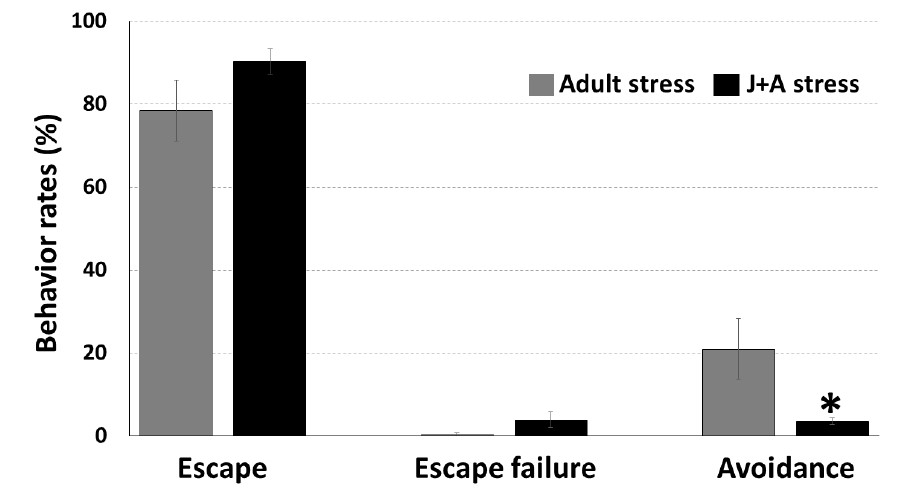
Figure 2. Rat behavior in the two-way shuttle avoidance task: Rats that were previously exposed to juvenile stress (J + A stress; n = 14) showed significantly lower rates of avoidance responses during the Two-Way Shuttle Avoidance (TWSA) test (the adult stress procedure) compared to rats that were exposed to the adult stress procedure without a prior exposure to juvenile stress (i.e., adult; n = 14). * Significant di ff erence from adults; p <